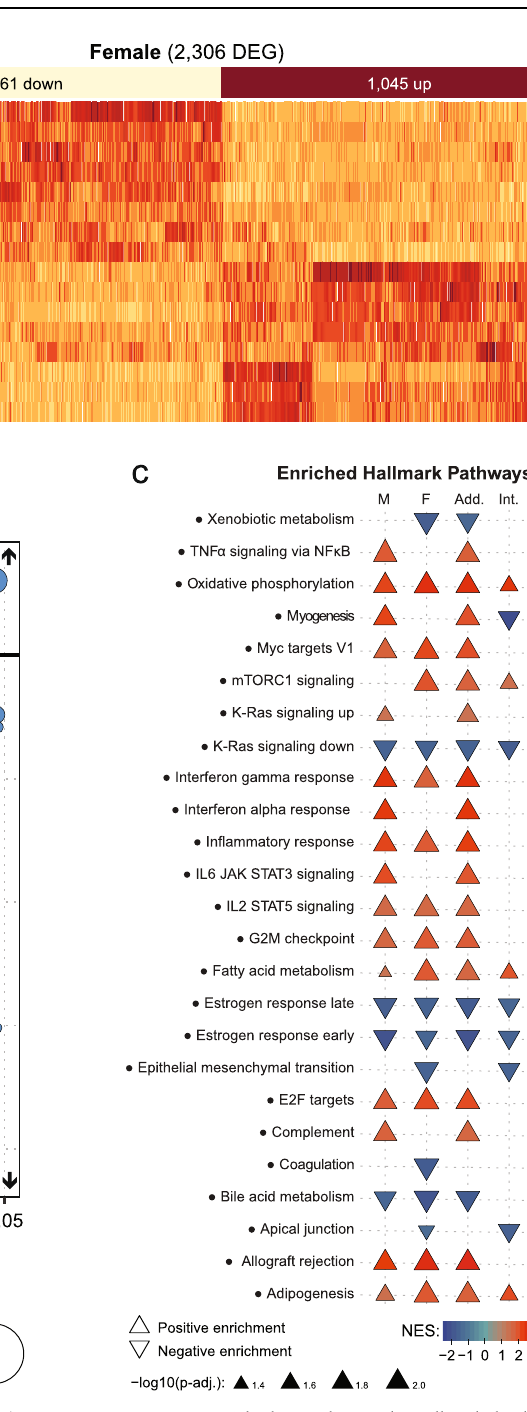
Fig. 4 | Sucrose intake elicits distinct transcriptional responses in adipose tis- sue from male and female mice. a Heat maps demonstrate a difference in the number of transcripts differentially expressed in inguinal adipose tissue following chronic liquid sucrose intake in each sex, as determined using negative binomial generalized models and Wald tests with Bonferroni correction in DESeq2 (MC: n =8, MS: n =8, FC: n =8, FS: n =8). b Bubble plot of the differentially expressed transcripts common to both male and female mice following sucrose intake demonstratingthelog2-foldchange(verticalspread),adjusted p -values(horizontal spread) and normalized count value (bubble size) for each sex as determined in a .